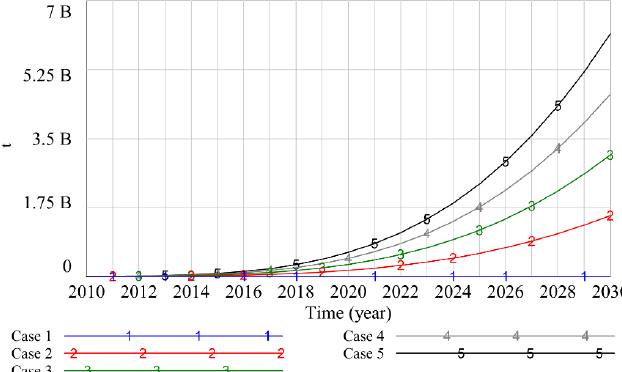
Figure 4. Variation in the landfill ratio adjustment coefficient.